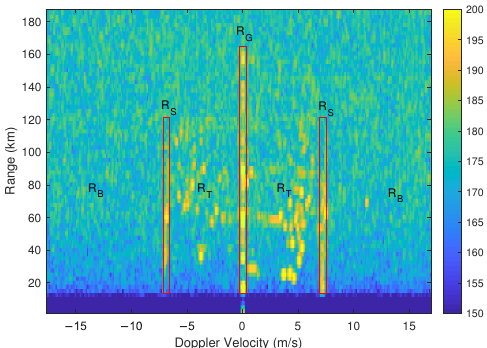
Figure 4. Different regions in an R-D